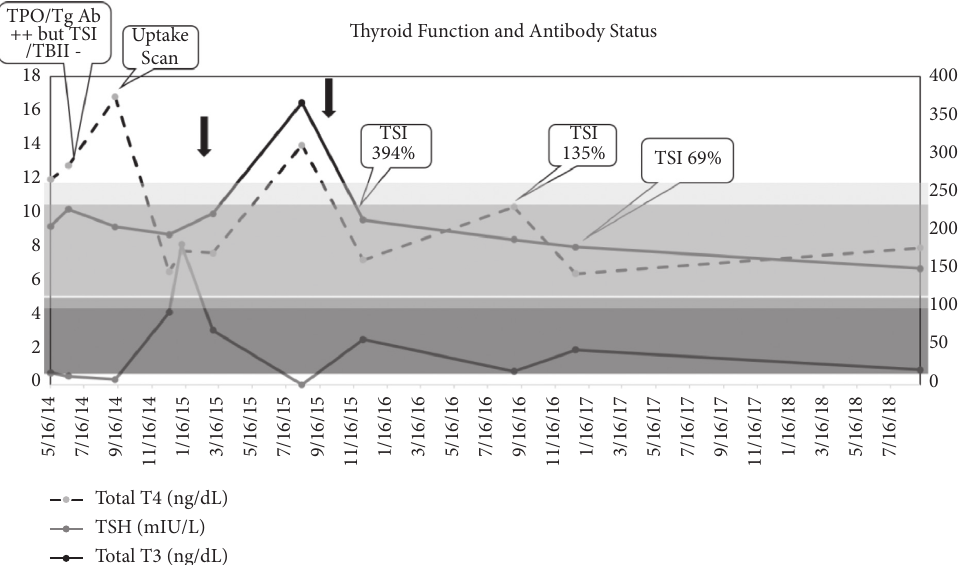
Figure 1: Thyroid course. TSH = thyroid stimulating hormone; TPO = thyroid peroxidase antibody; Tg Ab-thyroglobulin antibody; TBII = thyrotropin binding inhibitory immunoglobulin; TSI = thyroid stimulating immunoglobulins; arrow = glucocorticoid